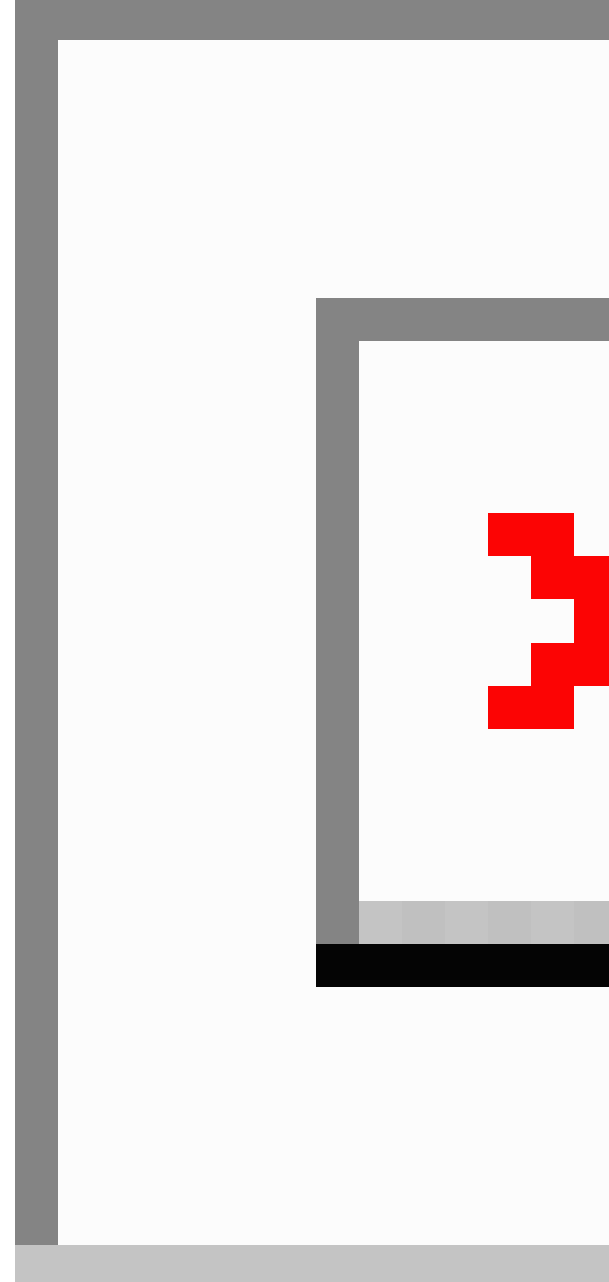
Figure 1. Equations (1) to